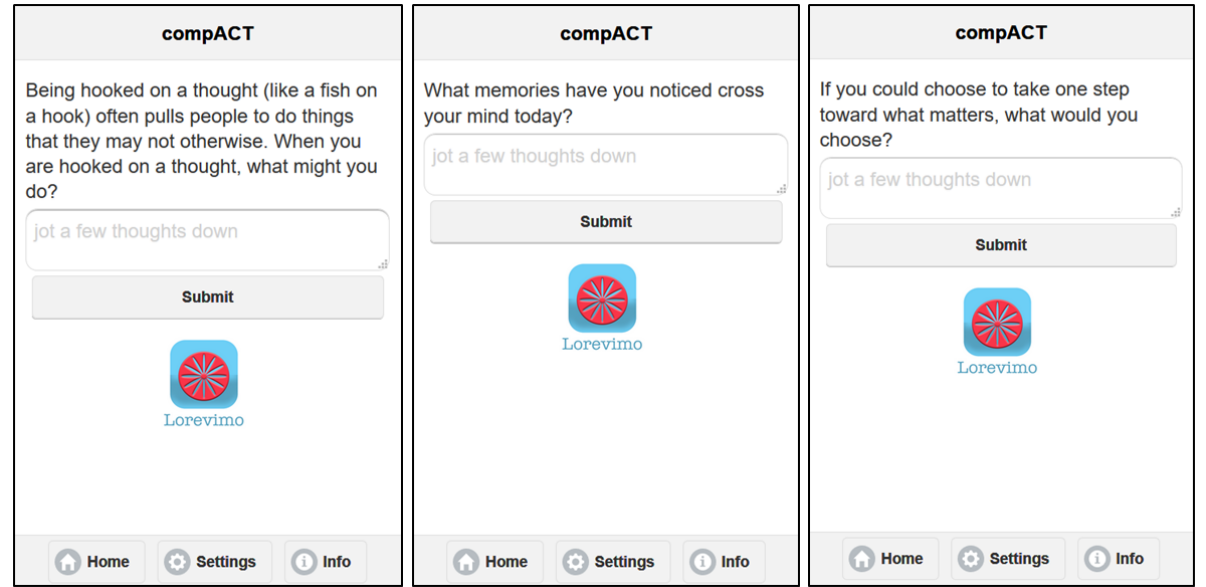
Figure 5. Microintervention examples from the Lorevimo app. These images reflect three of the 84 acceptance and commitment therapy (ACT)-based intervention questions, also allowing space for participants to enter a response. The first (left) is an openness question, the second (center) an awareness question, and the third (right) an engagement question. CompACT: Comprehensive Assessment of Acceptance and Commitment Therapy